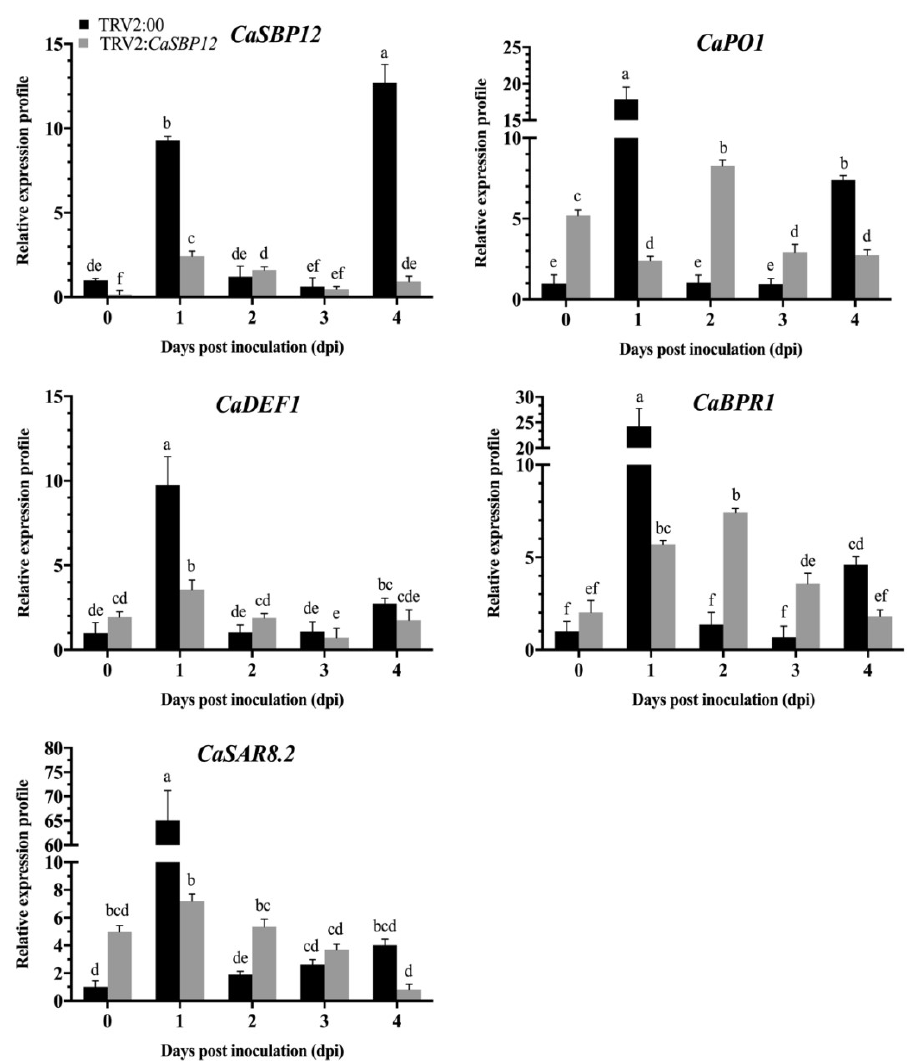
Figure 4. The expression of CaSBP12 and defense related genes after inoculation with the HX-9 strain of P. capsici in silenced and control plants. After measuring the silencing efficiency of the CaSBP12 gene, 5 mL of 1 × 10 5 cfu/mL zoospore of P. capsici were used to inoculate the silenced and control plants, respectively, using the root-drench method, and then roots of silenced and control plants were collected at 0, 1, 2, 3, and 4 d for the detection of defense related genes. CaPO1 ( Accession number: AF442386); CaDEF1 (Accession number: AF442388); CaBPR1 (Accession number: AF053343); CaSAR8.2 (Accession number: AF112868). The means were analyzed using the least significant difference (LSD). Bars with different lower-case letters indicate significant differences at p ≤ 0.05. Mean values and SEs for three replicates are shown.